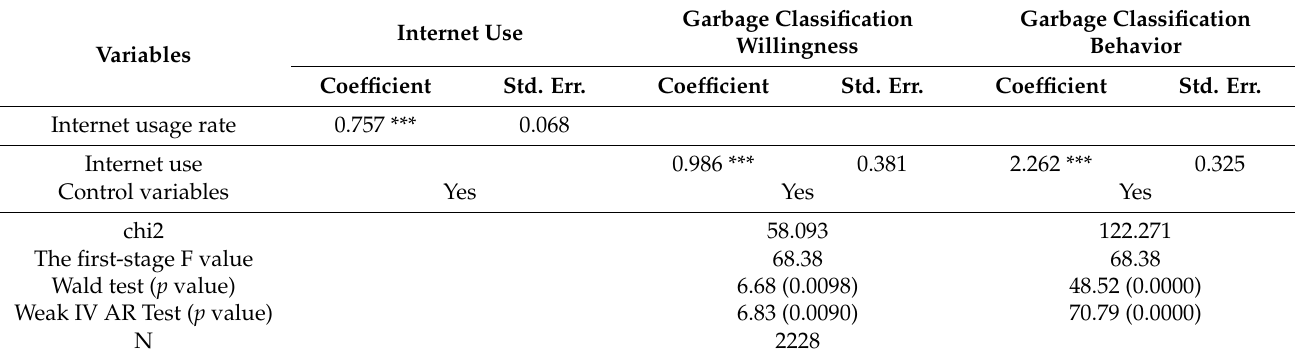
Table 4. Results of the endogeneity test.